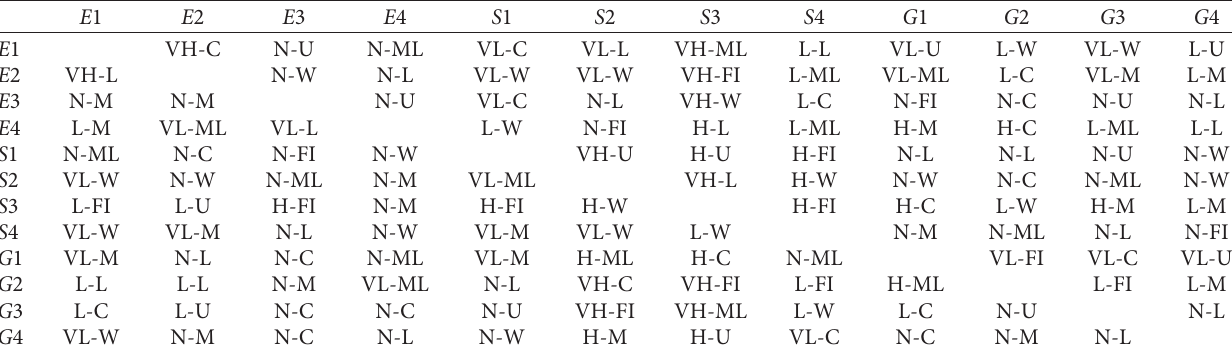
Table 20: Comparison matrix of the linguistic variable of sustainability criteria in Z-number condition.